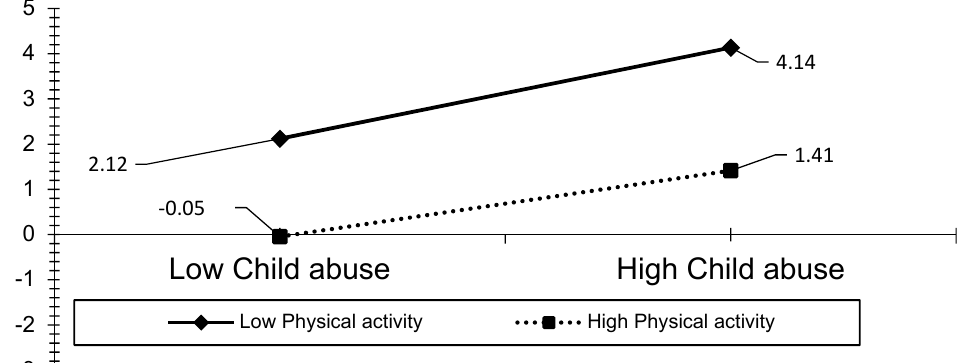
Figure 4. Model 5—Graph of interaction effect between PA and child abuse on physically un- healthy